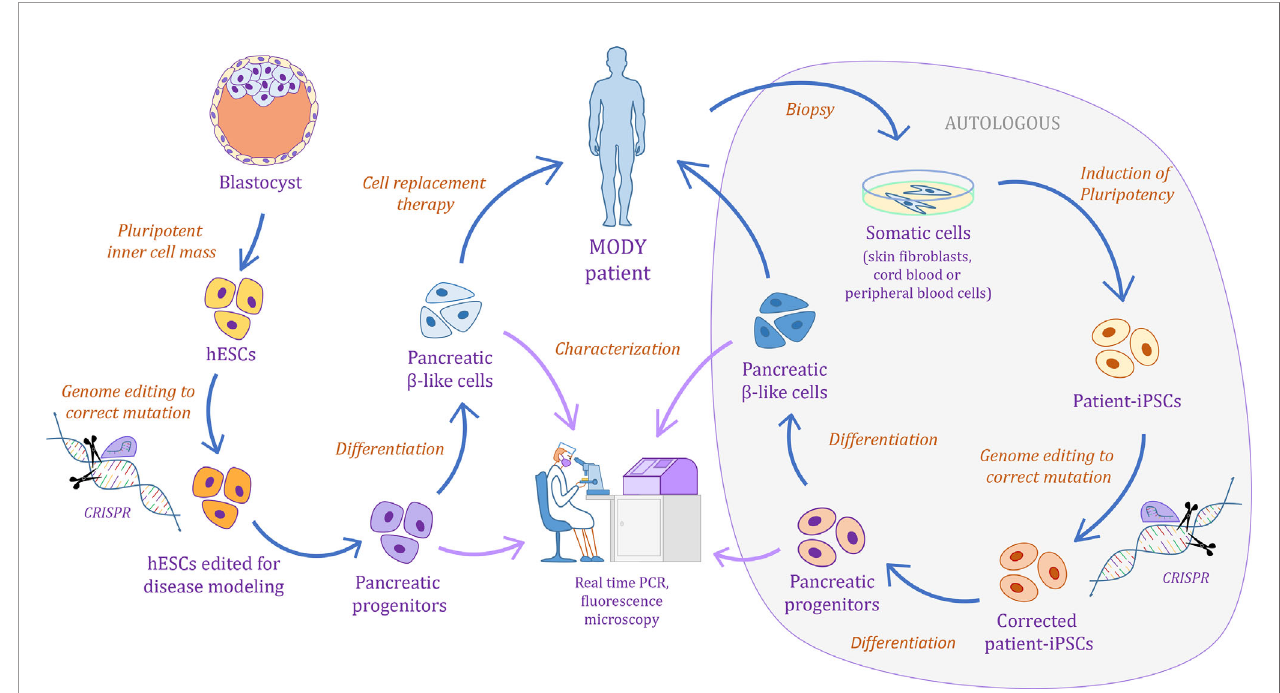
FIGURE 1 | Schematic illustrating the pipeline for monogenic diabetes disease modeling using human pluripotent stem